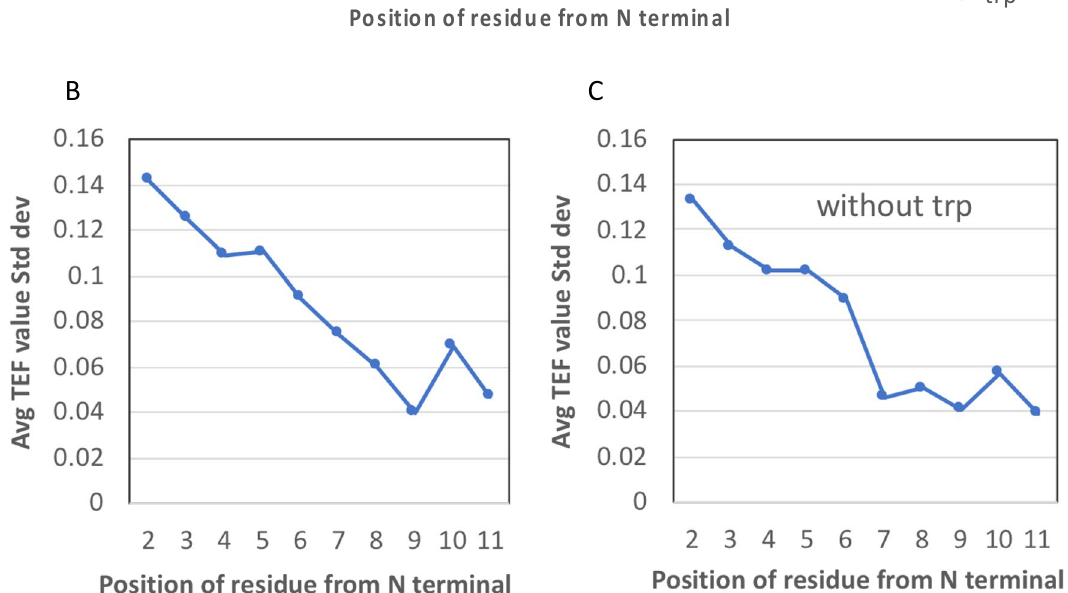
Figure 7. Positional effect of the amino acids on translational efficiency, from position 2 to 11. ( A ) Positional effect on translation of the 20 amino acids. Each TEF average value (see text for a definition of TEF) was established from about 200 to 1500 TEF data, depending on the position and the amino acid. Sequences for which a given amino was present in other position(s) than the one under investigation were removed. ( B ) Positional standard deviation (Std dev) of the average TEF values reported in ( A ). ( C ) Positional standard deviation (Std dev) of the average TEF values reported in A while excluding tryptophan (trp). Plots established from the TEF values listed in Supplementary File 1 of the work published by Sergiev et al. 5